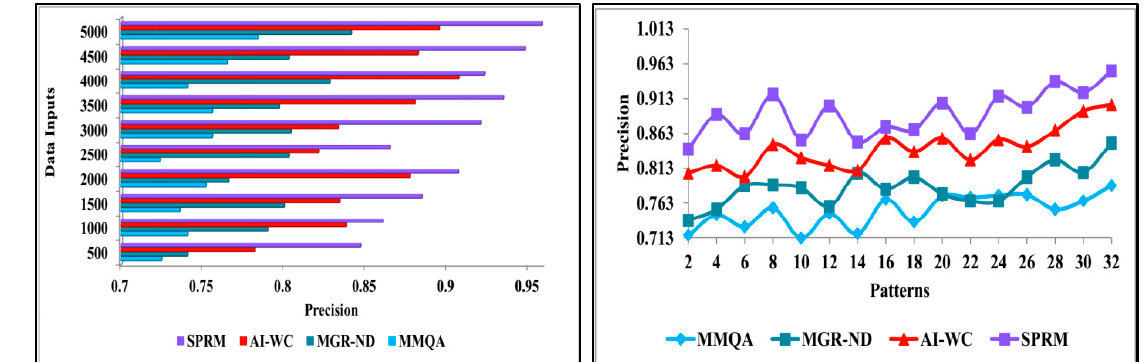
Figure 11. Precision